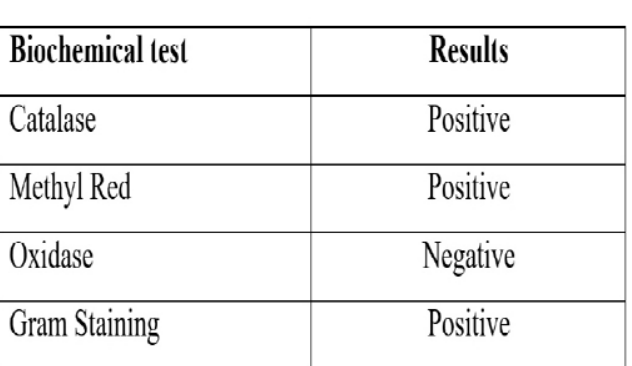
Table 6 Results of the Biochemical test